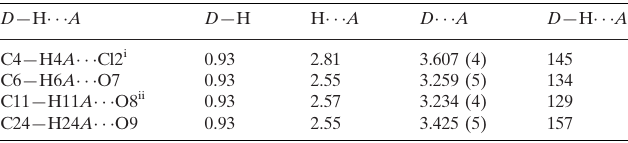
Hydrogen-bond geometry (A˚ , (cid:3) ). D —H (cid:2)(cid:2)(cid:2)